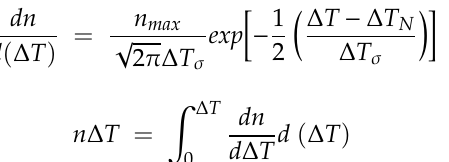
Table 1. Element contents and physical parameters of 26CrMoVTiB.